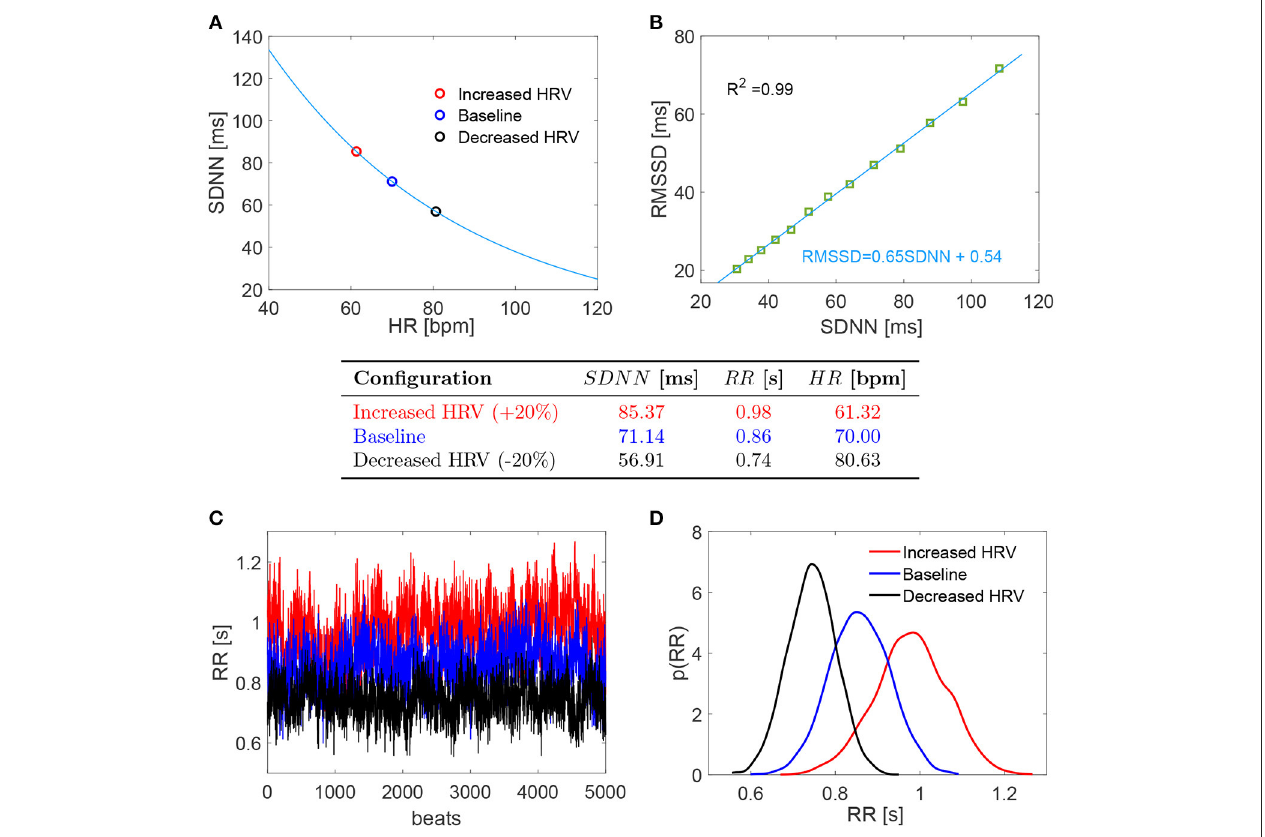
FIGURE 1 | (Top) (A,B) Relation SDNN (HR) and RMSSD (SDNN). (Middle) Table with the chosen values of the three configurations. (Bottom) (C,D) RR series and probability density functions of the three configurations. Red: increased HRV; blue: baseline; black: decreased HRV.